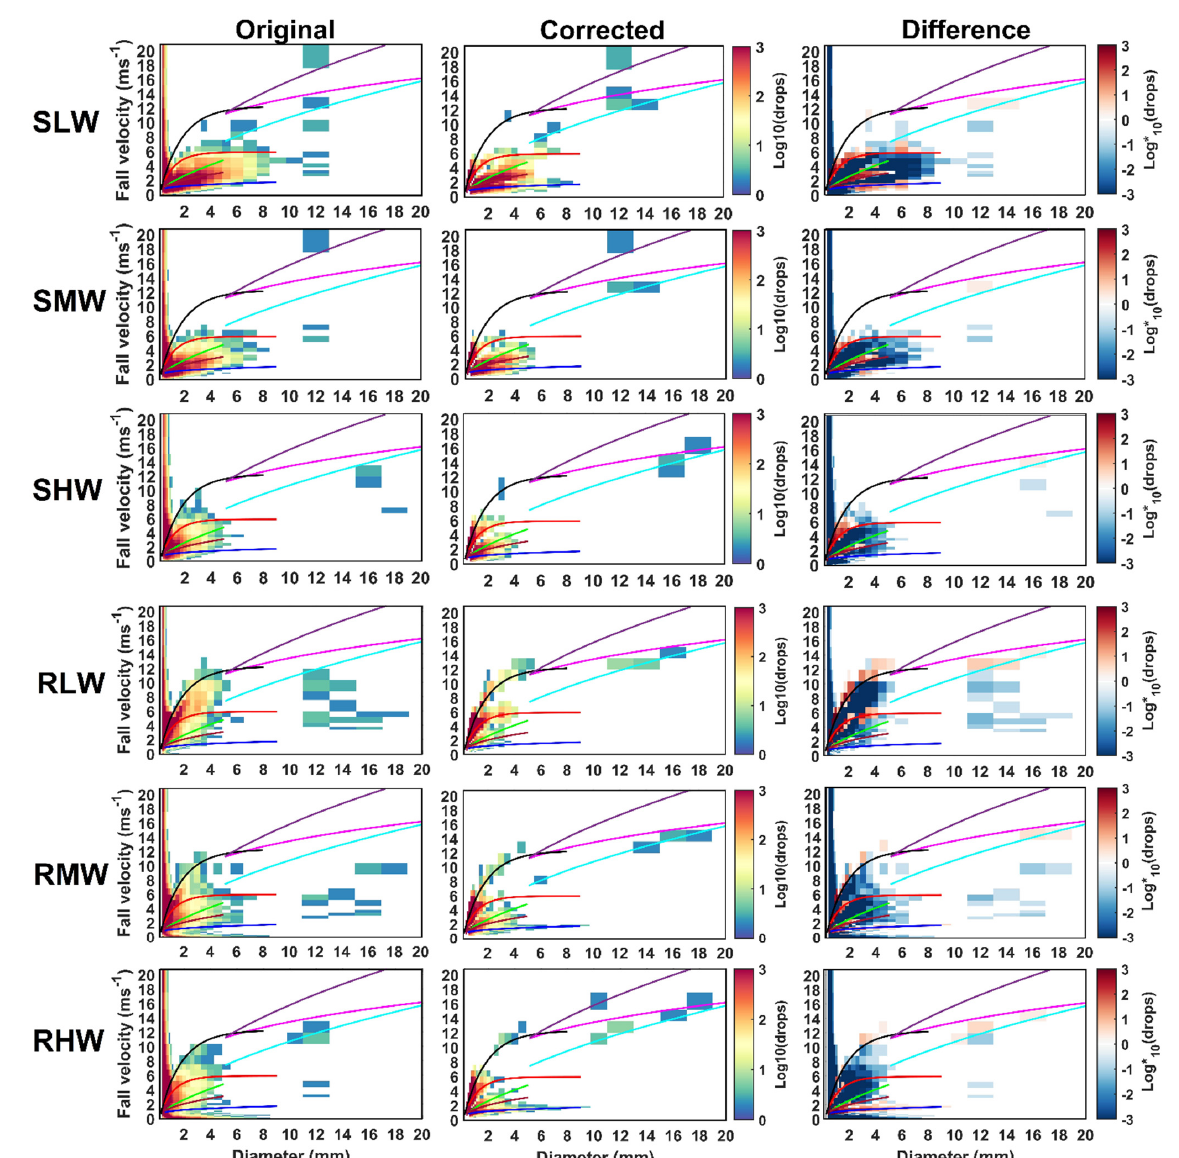
Figure 4. Scattergram of accumulated particle size distributions for each precipitation groups: solid with light wind ( SLW at first row), solid with moderate wind ( SMW at second row), solid with high wind ( SHW at third row), liquid with light wind ( RLW at fourth rows), liquid with moderate wind ( RMW at fifth row) and liquid with high wind ( RHW at sixth row). The original DSDs measured are shown in first column; corrected DSDs correspond to second column. Third column shows the bins affected by filters/corrections applied. Colorbar represents the logarithm of absolute values (Log* 10 ) of DSD dif including their sign. Red bins correspond to particles added and blue bins correspond to particles removed. Solid lines indicate the fall velocity–diameter relationships for each type of hydrometeor: raindrops (black), wet snow (red), snow (blue), lump graupel (green), graupel (brown), soft hail (light blue), lump hail (purple), and fresh hail (dark